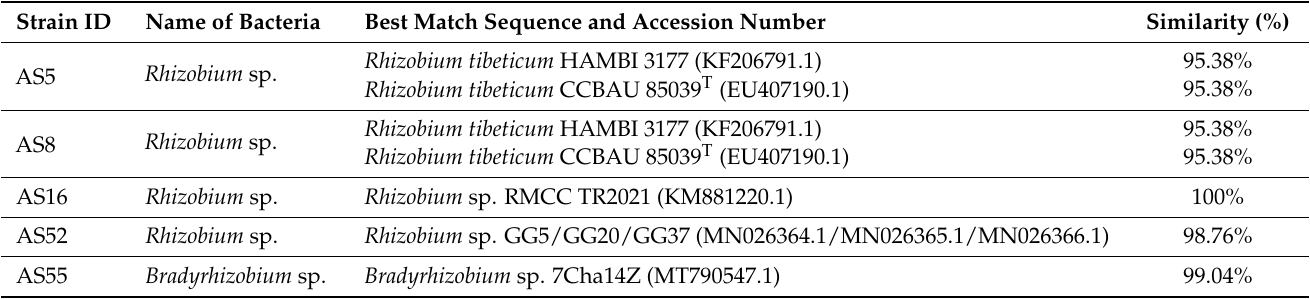
Table 1. Identification based on glnII gene sequences of the rhizobia isolates.